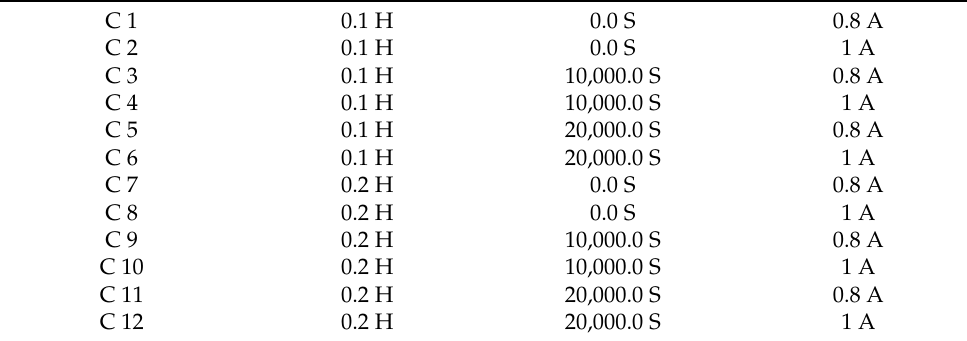
Table 4. Different possible combinations of H, S, and A.